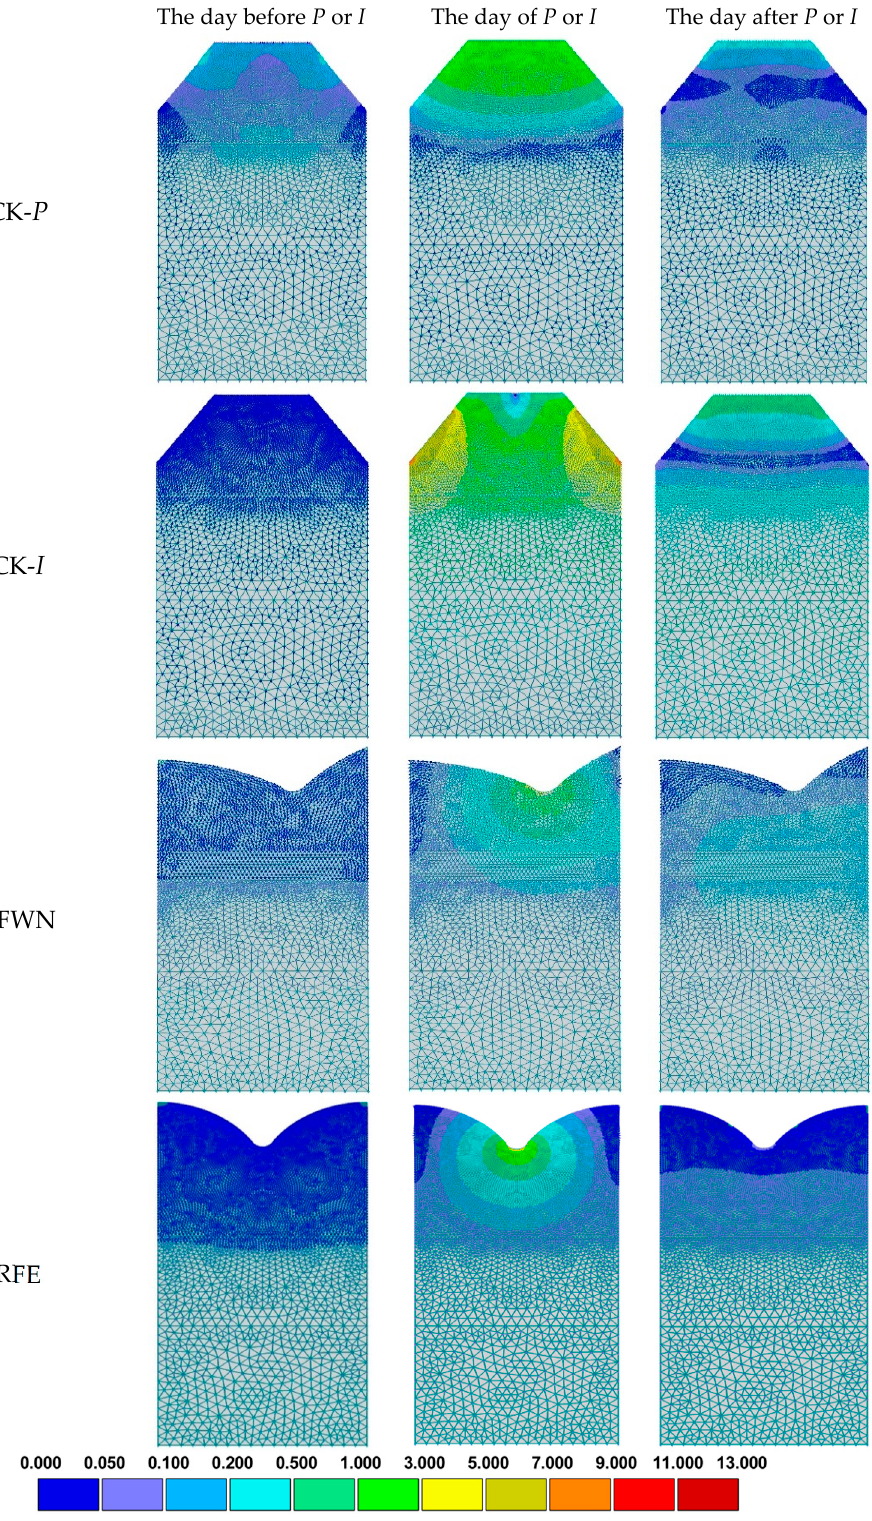
Figure 6. Simulated water flow vectors during a rainfall or irrigation; P represents rainfall event and I represents irrigation event.